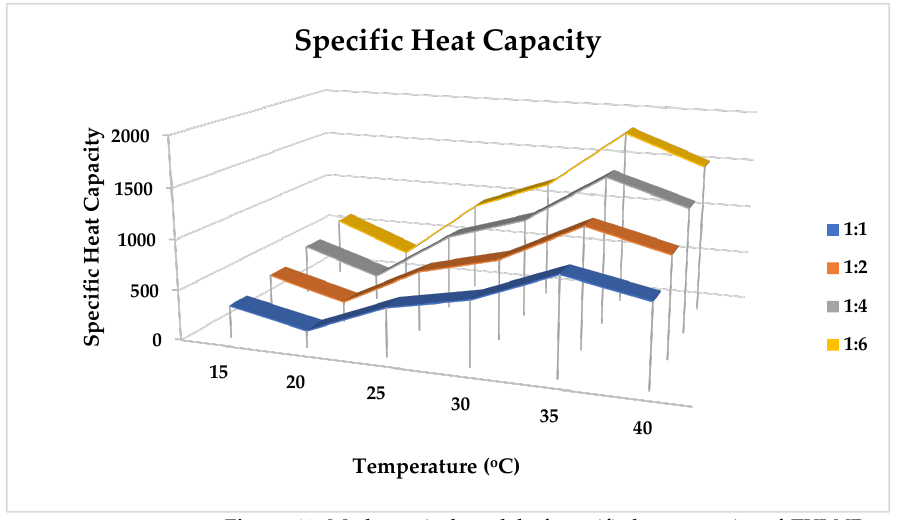
Figure 12 . Mathematical model of specific heat capacity of ZVI - NPs at a particular temperature range of (1 5– 40 °C) along with the solvent mixing at 1:1, 1:2, 1:4 , and 1:6. Figure 12. Mathematical model of specific heat capacity of ZVI-NPs at a particular temperature range of (15–40 ◦ C) along with the solvent mixing at 1:1, 1:2, 1:4, and 1:6.